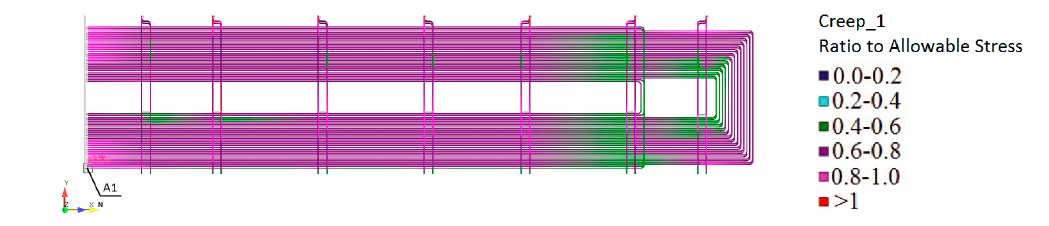
Figure 4. Ratio of longitudinal stress to allowable stress for the superheater after 200,000 h of operation under creep conditions.